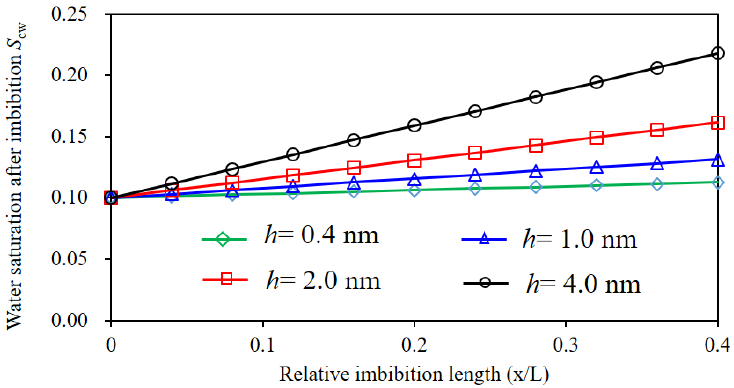
Figure 5. Effect of imbibition on water saturation.